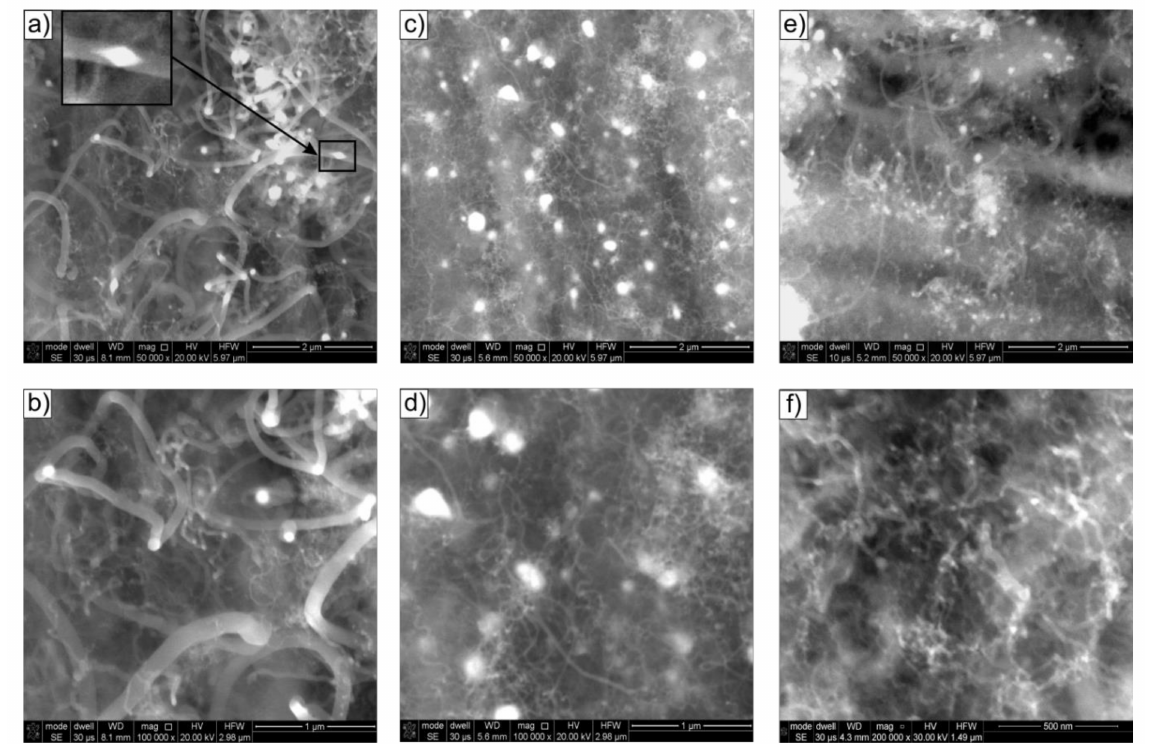
Figure 2. SEM morphology of Ni 3 Al foils surface after ethanol decomposition without water steam addition (mixture #1) at: ( a , b ) 500 ◦ C, ( c , d ) 600 ◦ C, and ( e , f ) 700 ◦